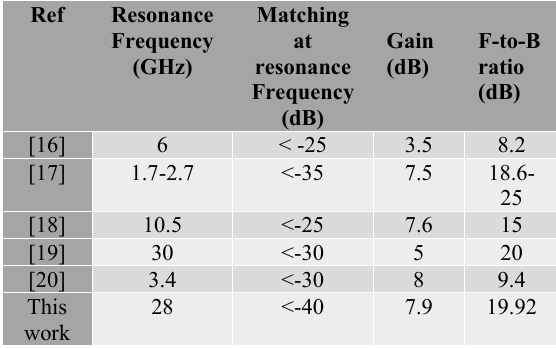
Table 2. Comparisons between the proposed antenna and other